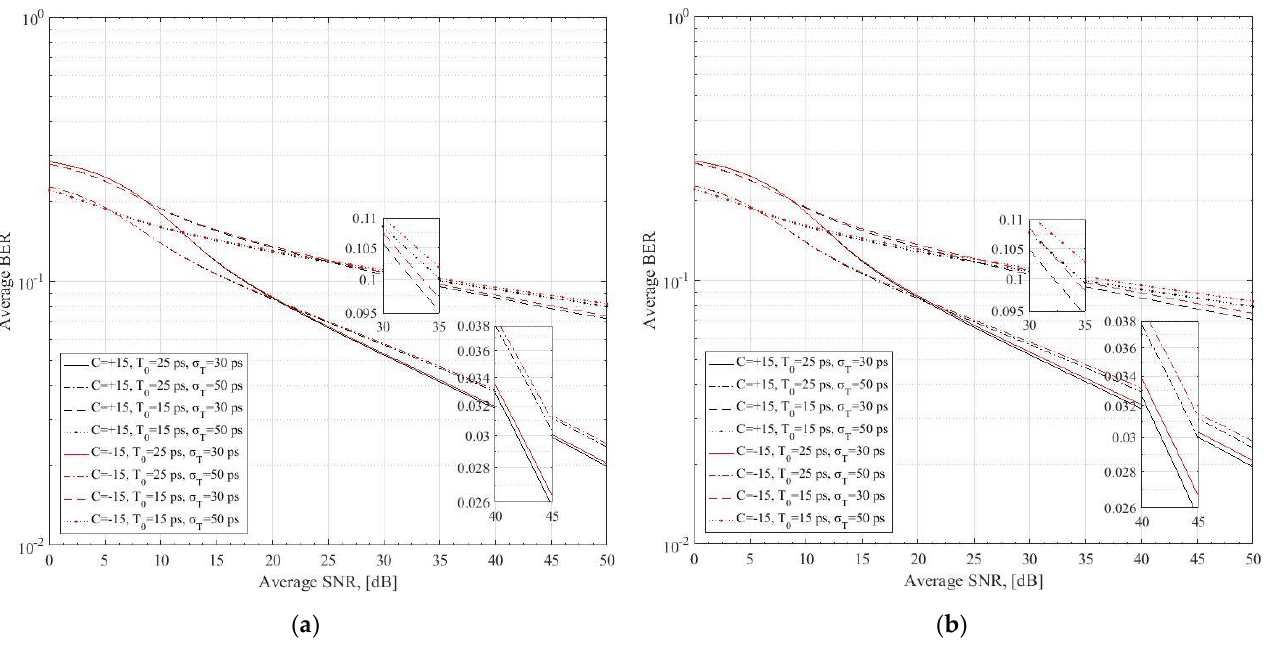
Figure 3. Average BER as a function of the average SNR with various original pulsewidths, TJ strength parameters, and opposite chirp values for an FSO link of ( a ) z = 5 km and ( b ) z = 10 km.